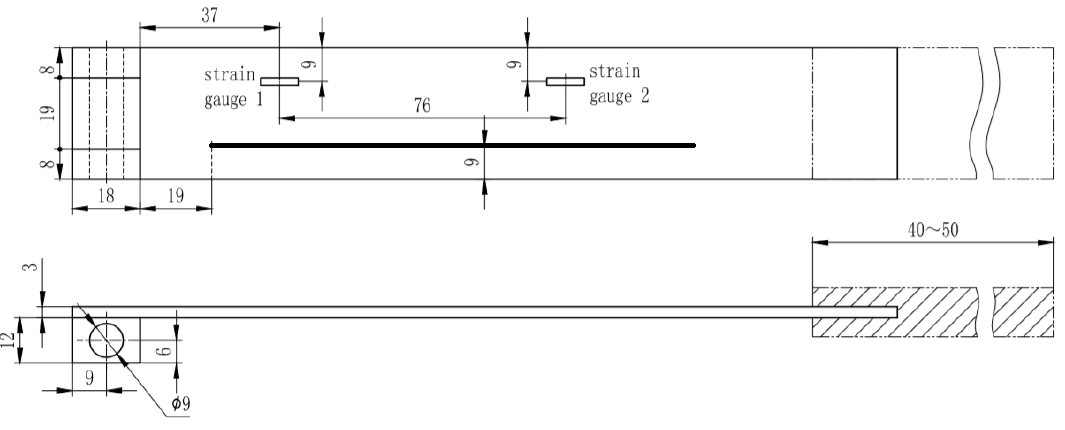
Figure 3. Specimen geometry and test set-up.